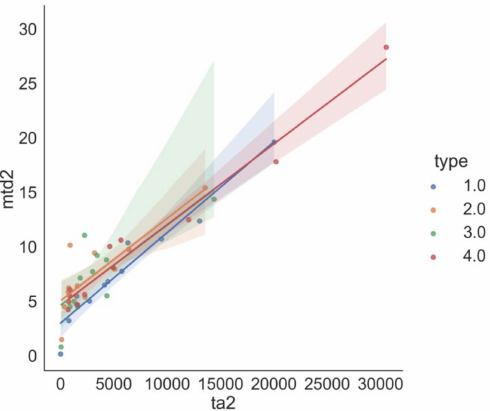
Figure 10. Maximum track depth versus track area—fluid friction (very strong positive correla- tion